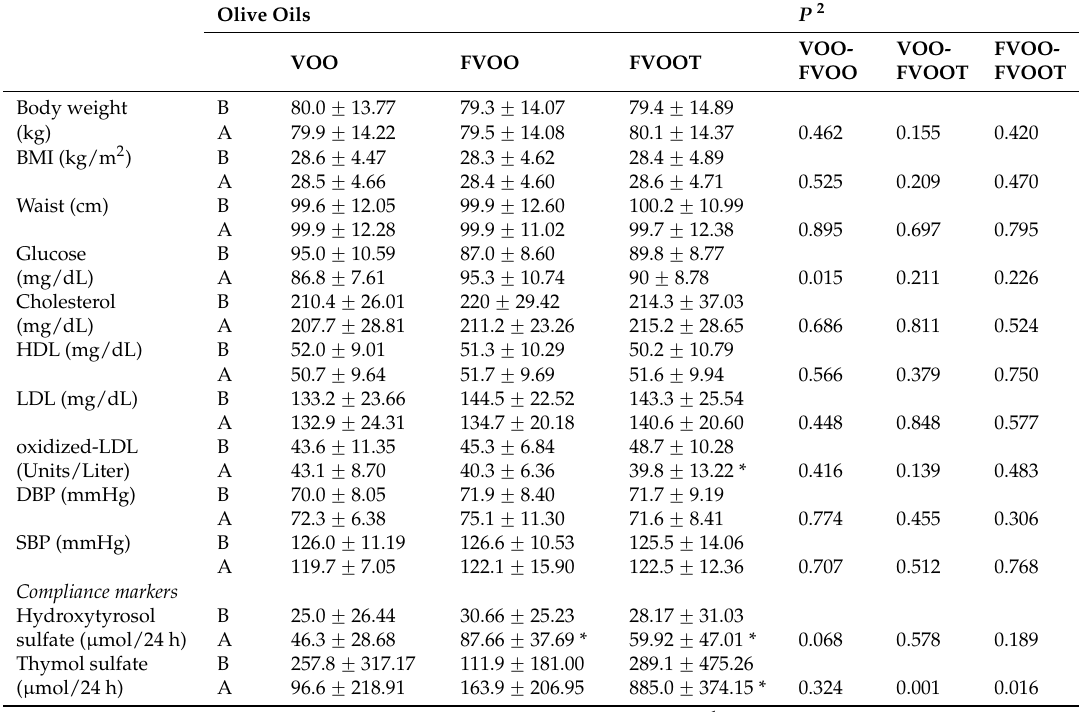
Table 2. Systemic parameters and compliance markers before (B) and after (A) each OO intervention 1 . Olive Oils